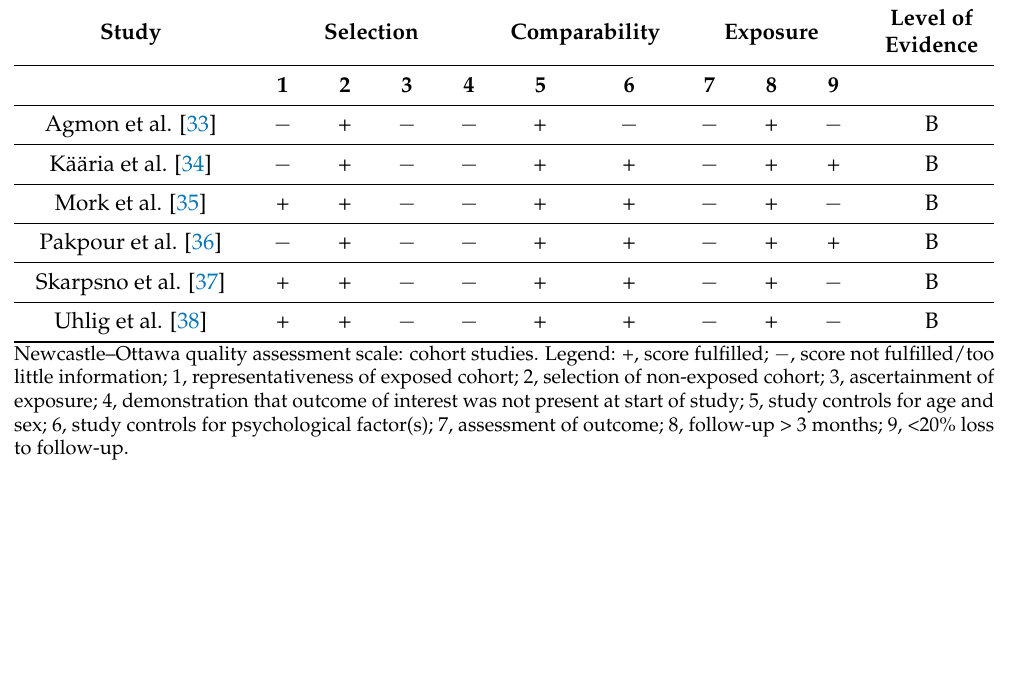
Table 2. Methodological quality of cohort